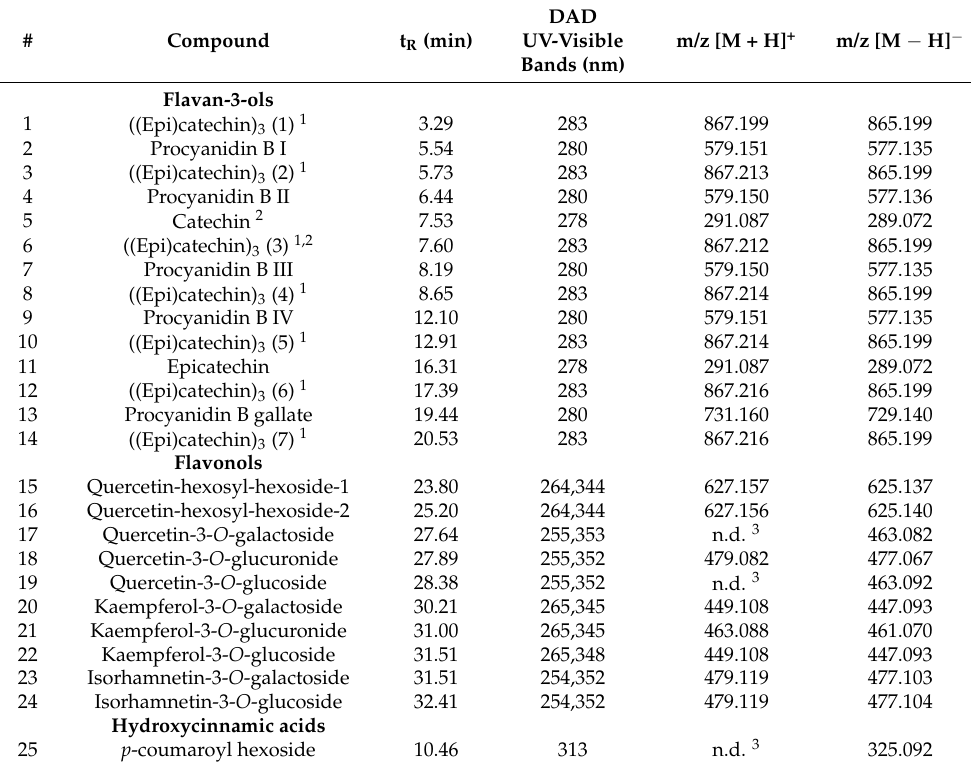
Table 1. Identification of phenolic compounds in Tempranillo grape pomace extract determined by using UHPLC-DAD-ESI-QToF/MS analysis.